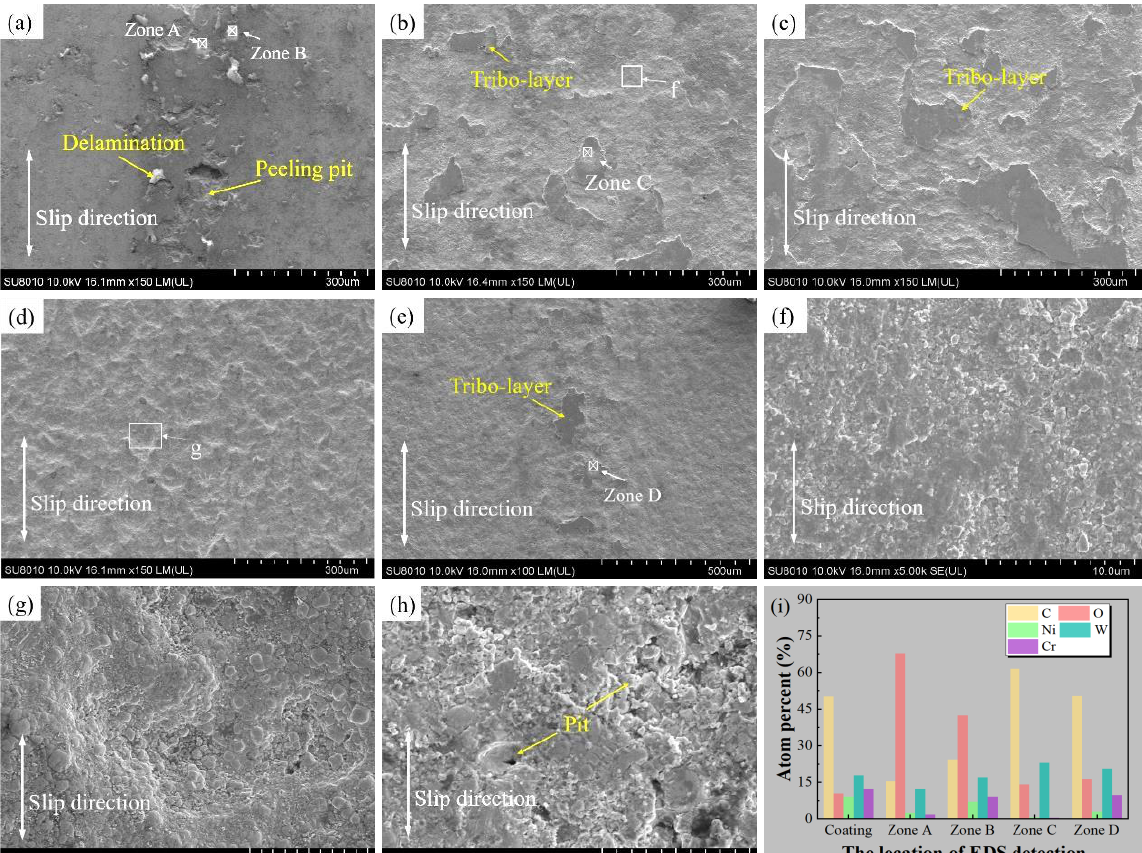
Figure 5. Surface morphology and EDS analysis of coating wear scars under different sizes of particle conditions: ( a ) no particles; ( b ) 1.5 μ m; ( c ) 4 μ m; ( d ) 12 μ m; ( e ) 36 μ m; ( f ) the enlargement of the region in ( b ); ( g ) the enlargement of the region in ( d ); ( h ) 36 μ m , local area without tribo−layers; ( i ) the location of EDS detection.